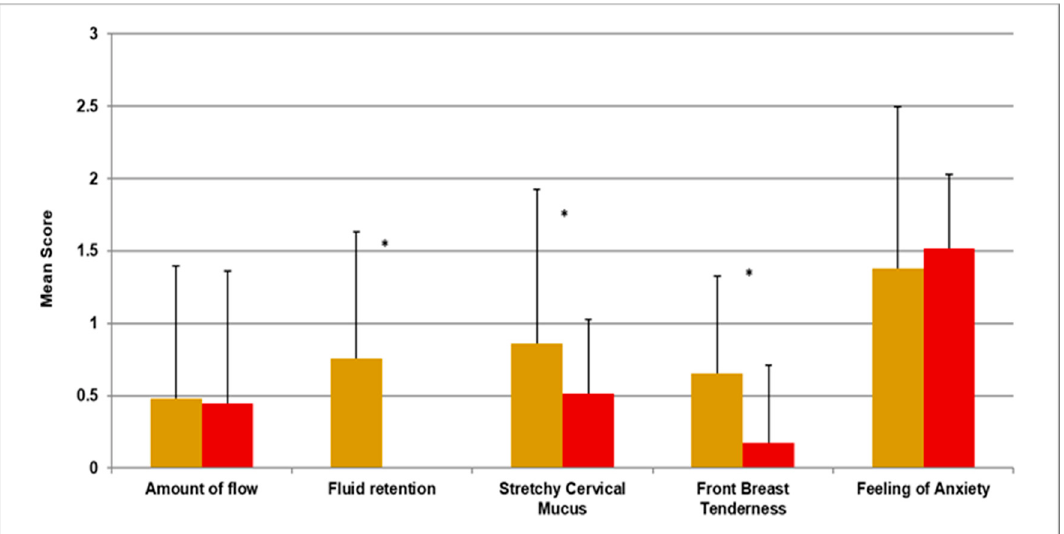
Figure 1. Cycle 1 (gold) versus 6 (red) using the Wilcoxon Paired Signed Ranks Test. * noted above data indicates a significant change of p ≤ 0.05.